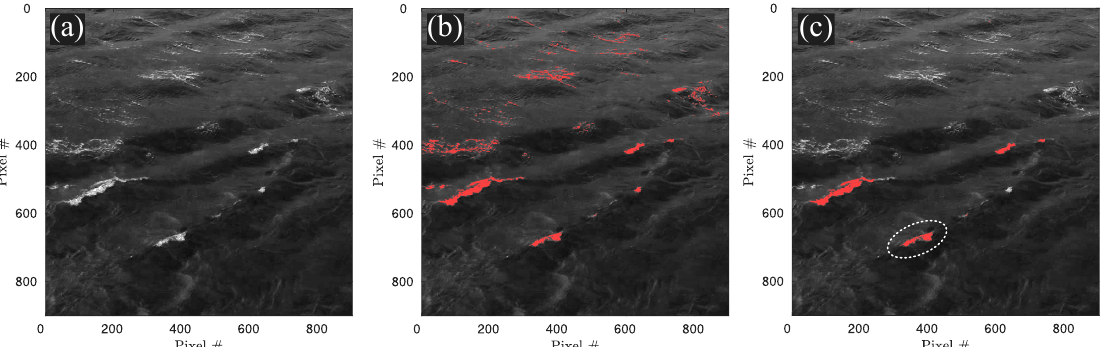
Figure 3. ( a ) An example of a grayscale image of the sea surface with breaking waves on 24 September 2013 at around 12:34 (UTC + 3H). ( b ) The same with detected foam using brightness threshold and ( c ) with extracted active foam. A breaking crest outlined in plot ( c ) is shown in Figure